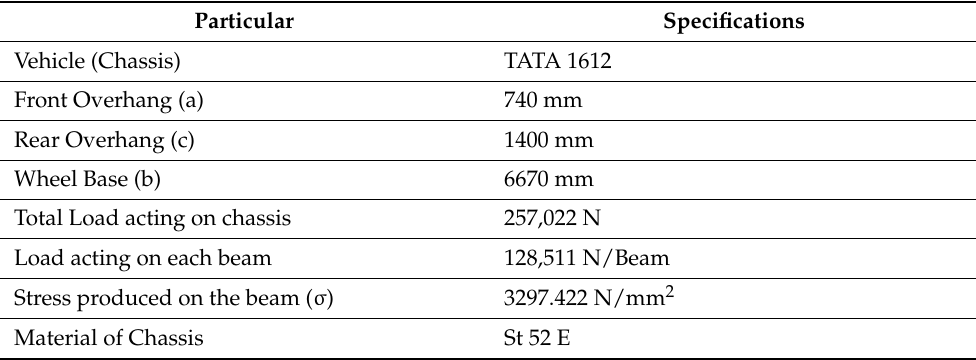
Table 1. Specifications of TATA 1612 chassis [27].